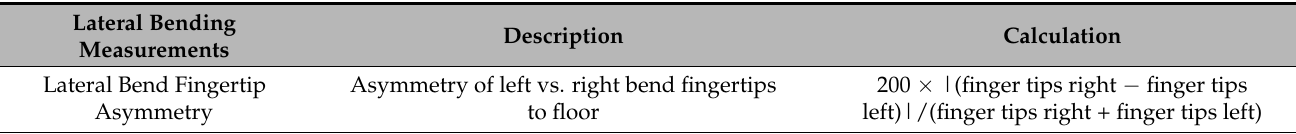
Table 1. Lateral and forward bending